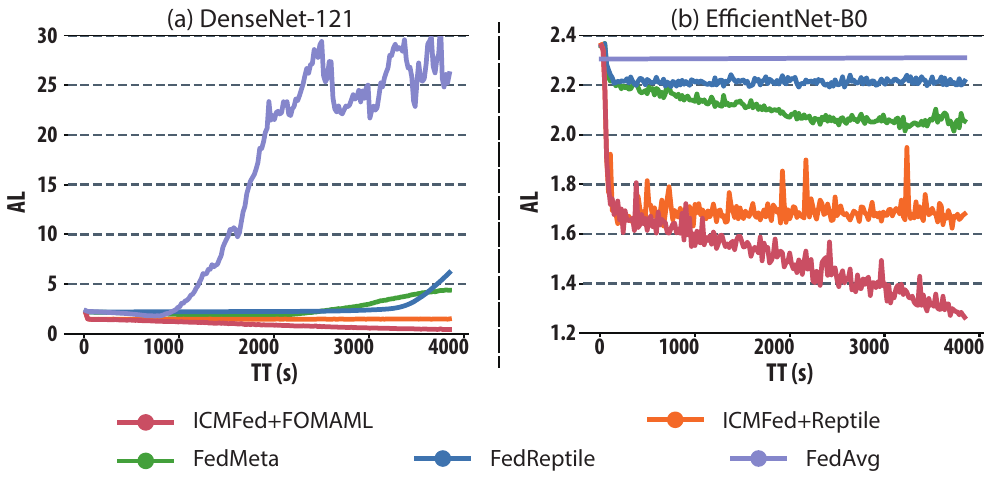
Figure 5. Relationship between AL and TT in ( a ) DenseNet-121 and ( b )